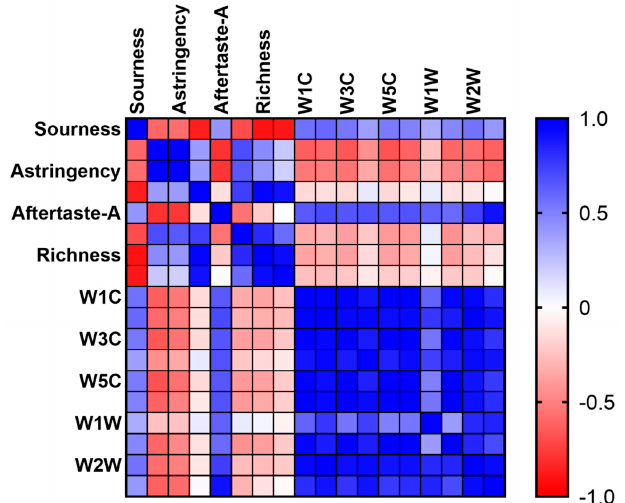
Figure 8. Correlation analysis between E-nose and E-tongue; blue represents a positive correlation, and red represents a negative correlation.